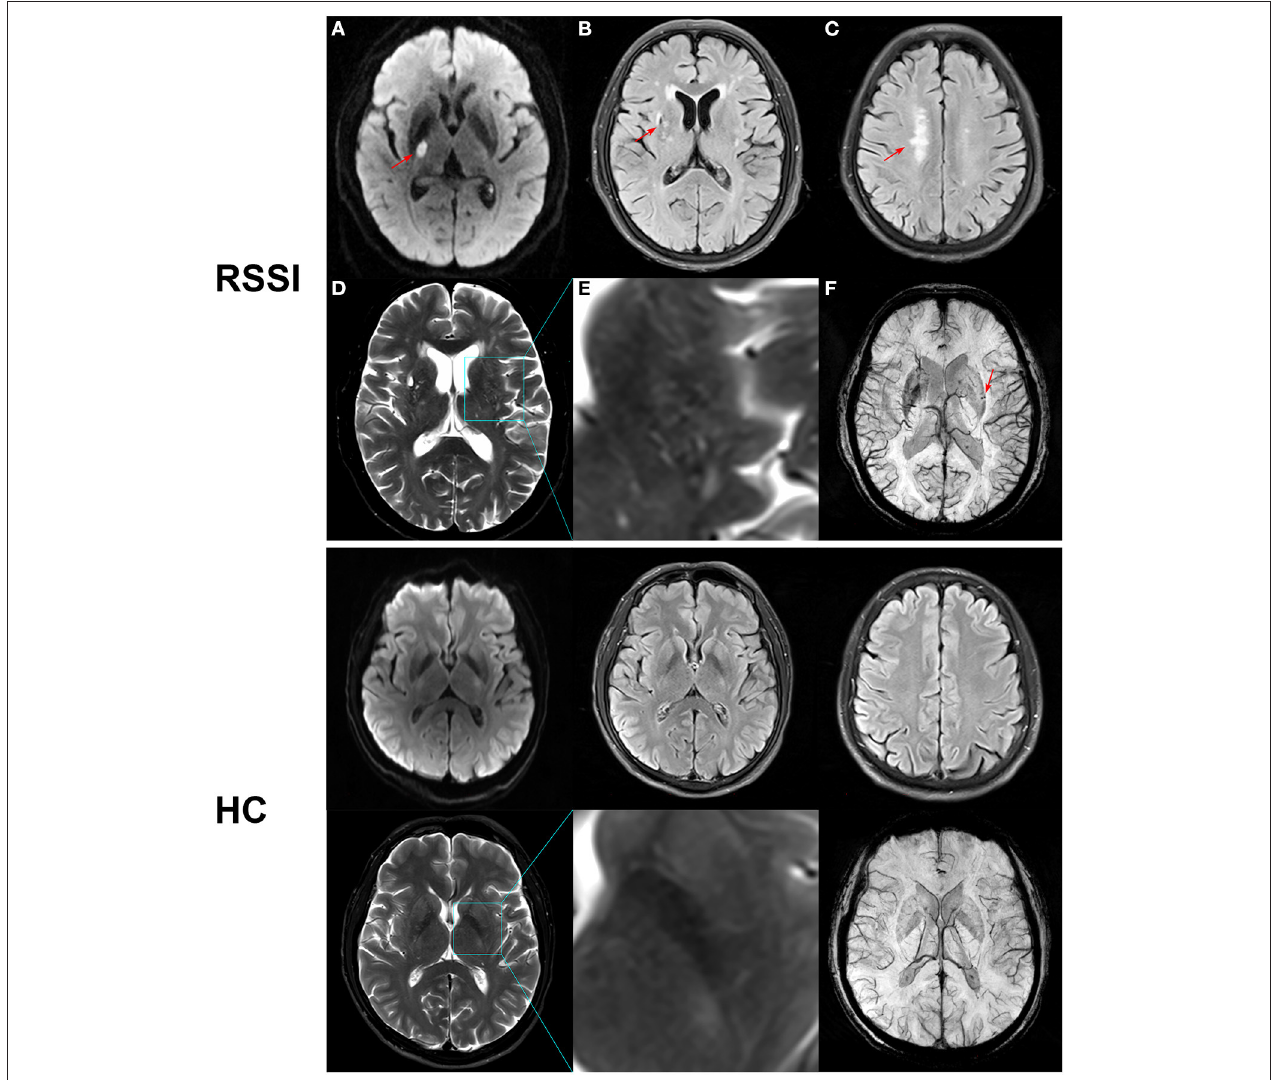
FIGURE 1 | Representative MR images of recent subcortical infarction (RSSI) and healthy control (HC). Upper row: (A) DWI showed an acute single subcortical infarction in the right basal ganglia (arrow). (B) FLAIR showed a chronic lacune in the right basal ganglia (arrow). (C) FLAIR showed deep white matter lesions (arrow) with a Fazekas score of 2. (D) T2WI showed moderate enlarged perivascular space in the basal ganglia. (E) Magnified image of the outlined region indicated in (D) . (F) SWI showed cerebral microbleeds in the left basal ganglia. This patient had a total CSVD score of 4. Bottom row: A 55-year-old healthy control showed normal MR images with a total CSVD score of